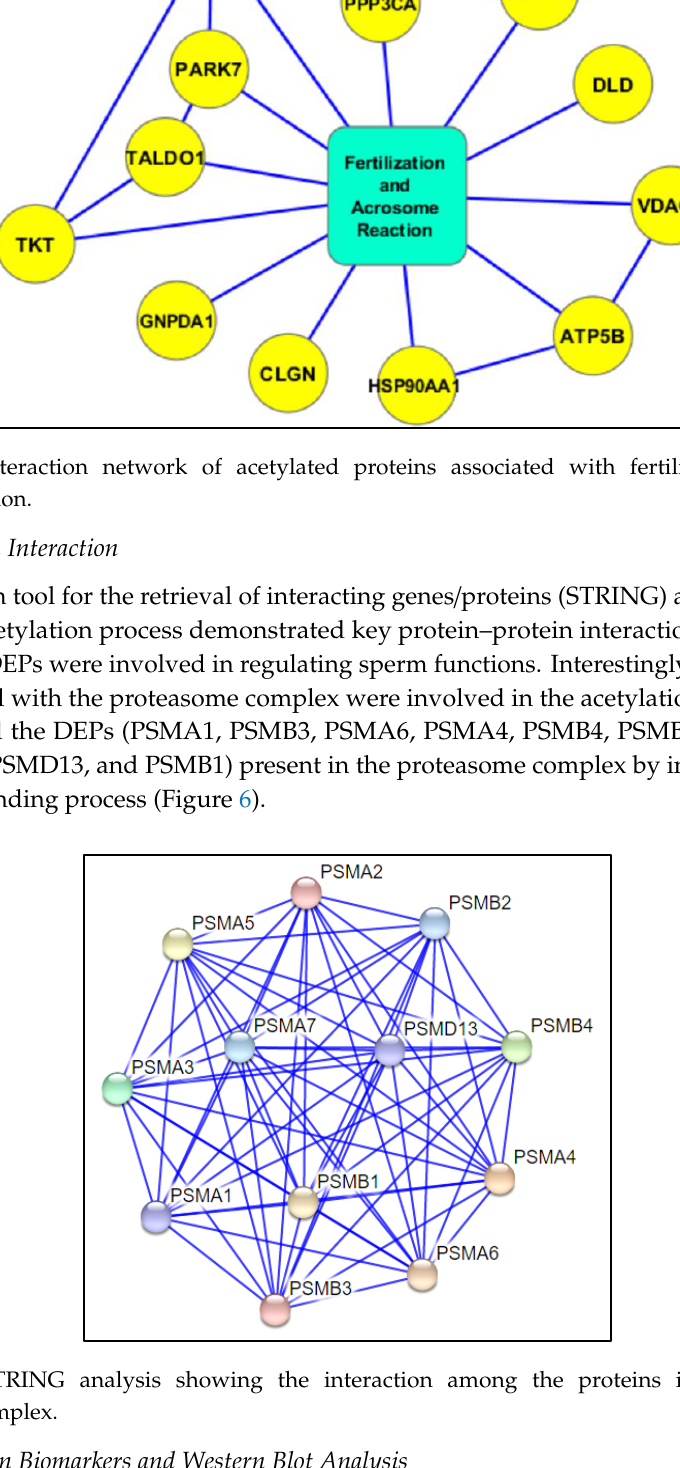
Figure 4. Interaction network of acetylated proteins associated with oxidative stress.